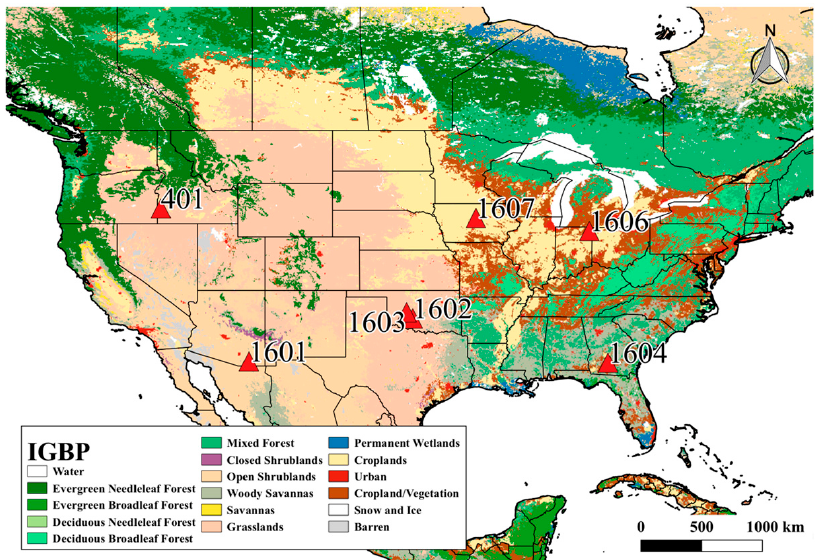
Figure 1. Locations of Agricultural Research Service (ARS) sites that are core validation sites (CVS) for the Soil Moisture Active Passive (SMAP) satellite mission. The background is the MODIS Land Cover product (MCD12Q1) (http://glcf.umd.edu/data/lc/).